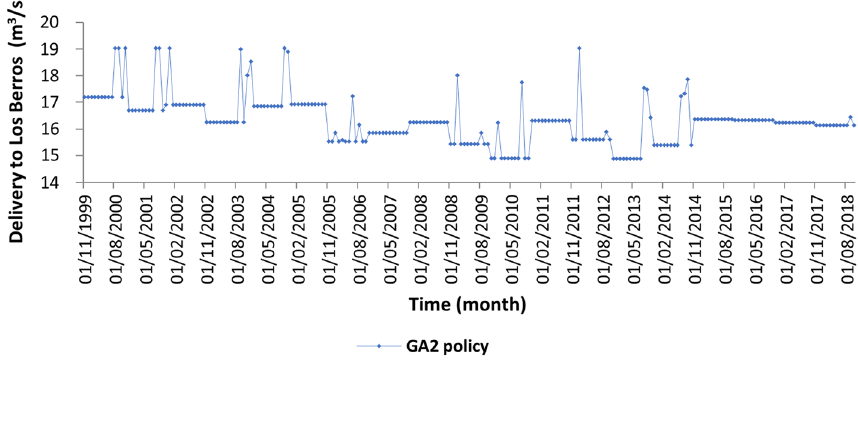
Fig. 8 The monthly initial water storage level of the El Bosque reservoir: the historical record versus the simulated values found with genetic algorithm GA2